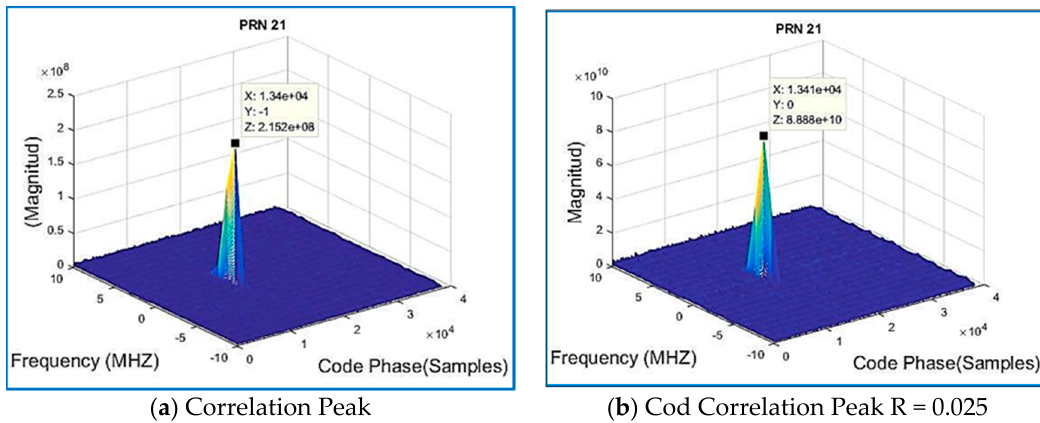
Figure 15. Frequency domain, histogram, real waveform, and raw I/Q of Dataset 3. Figure 16. Navigation solution of Dataset 3 (not compressed).